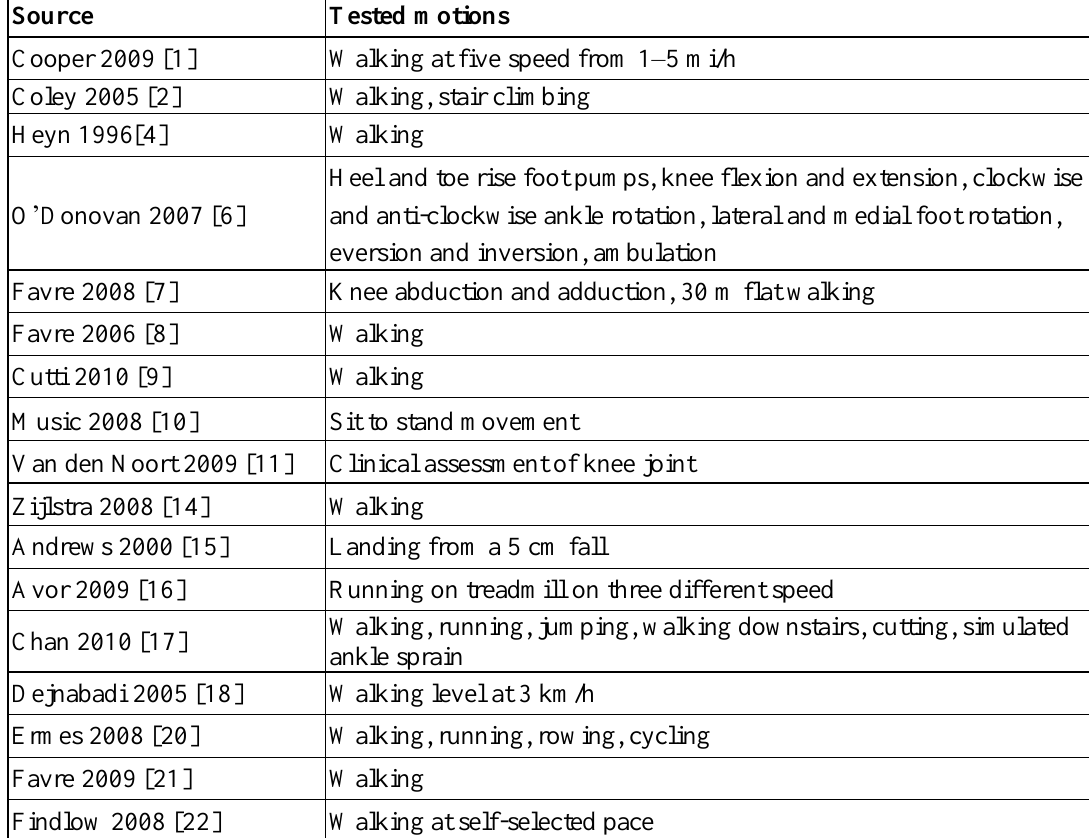
Table 2. Motions involved in reviewed